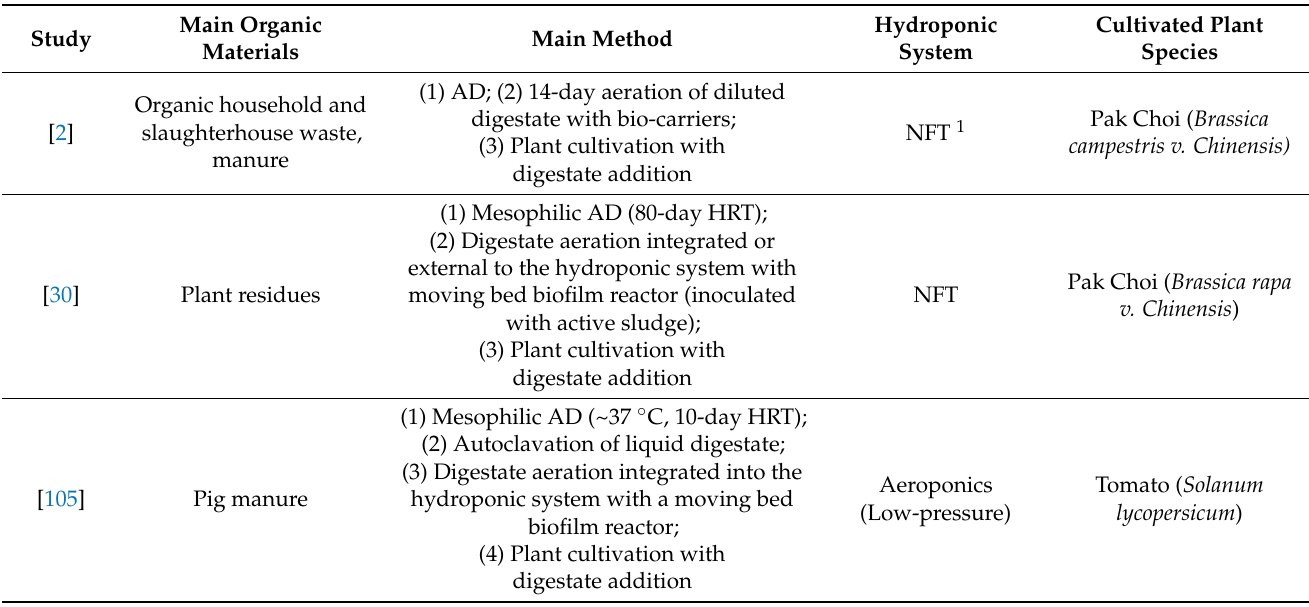
Table 6. Main organic materials and method of combined anaerobic and aerobic degradation for the production of nutrient solution used in different types of